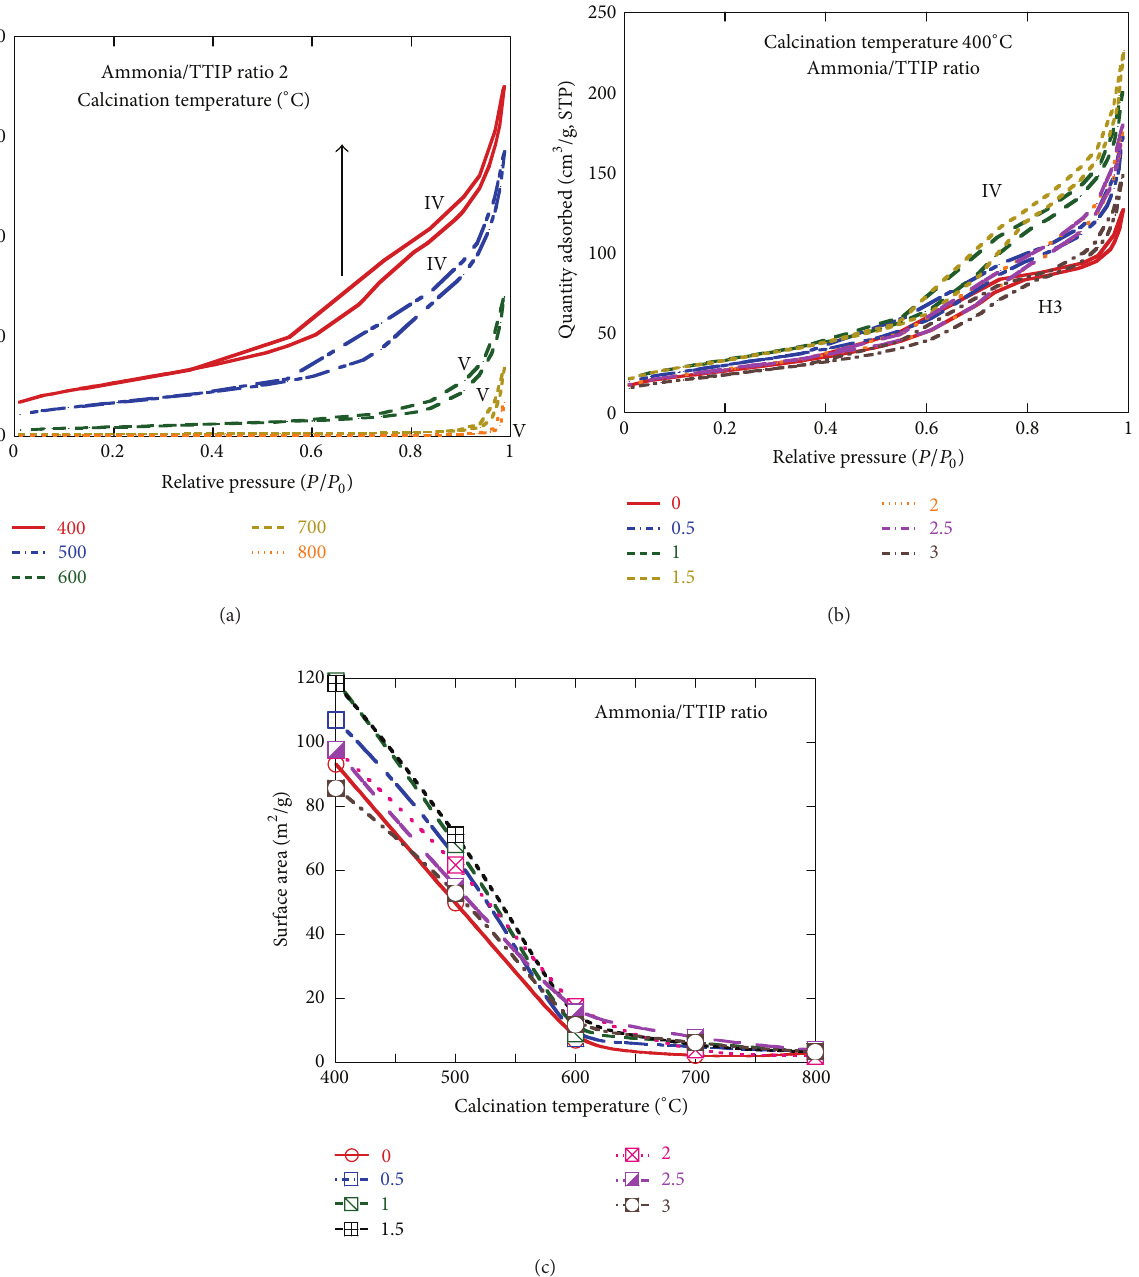
Figure 5: Nitrogen adsorption and desorption isotherms of N-TiO 2 samples (a) calcined at various temperatures, (b) prepared with various ammonia/TTIP molar ratios; the surface area as a function of calcination